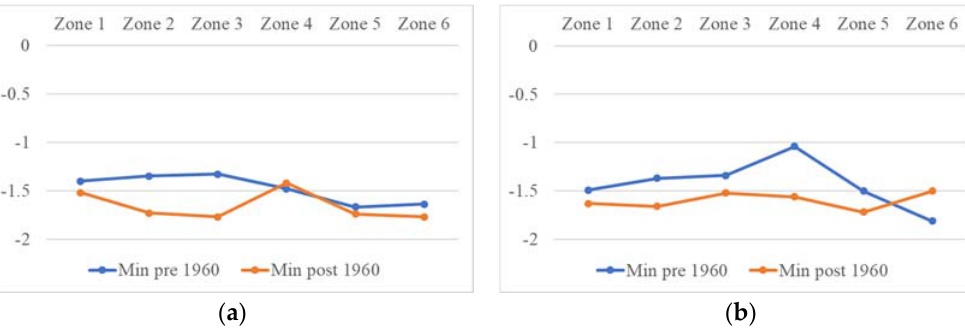
Figure 18. ( a ) 3-month and ( b ) 12-month SPEI minimum drought intensity. Figure 18. ( a ) 3 ‐ month and ( b ) 12 ‐ month SPEI minimum drought intensity.